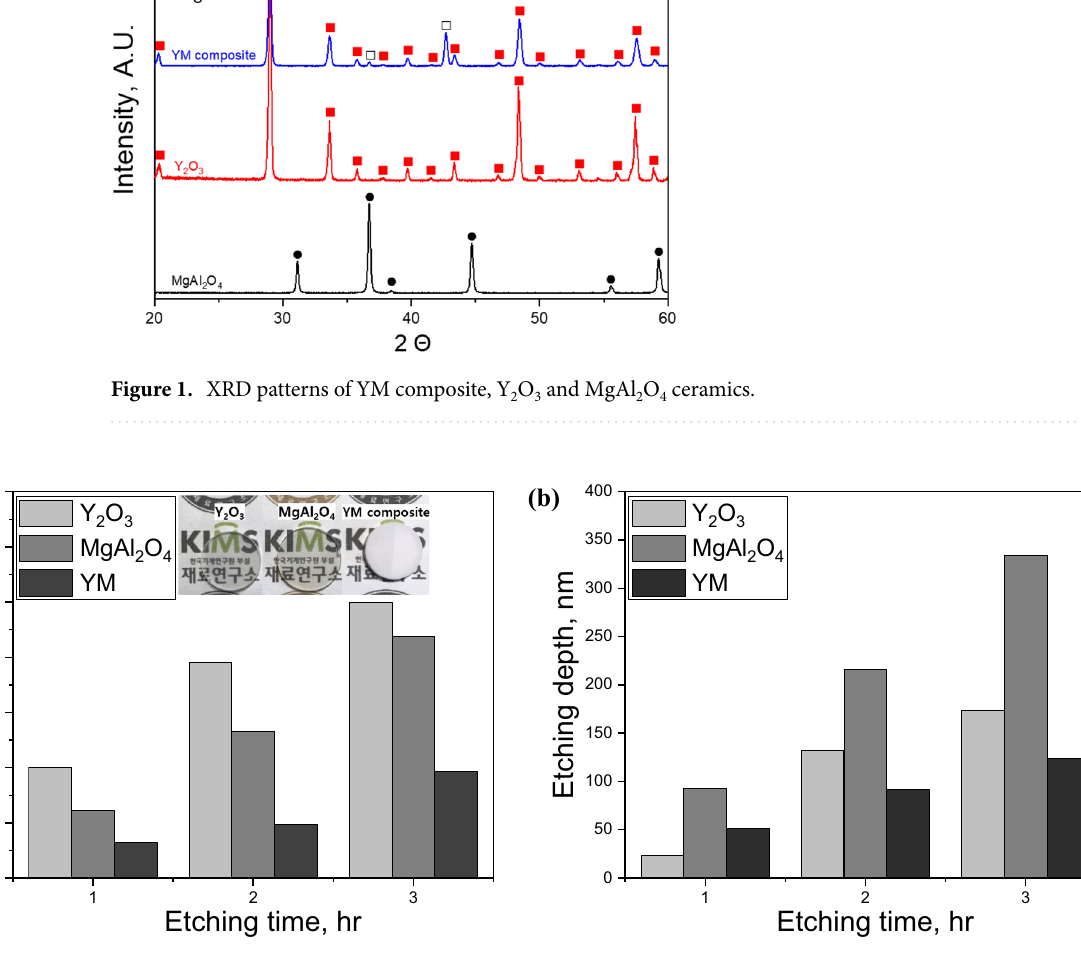
Figure 2. The measurement of ( a ) mass loss and ( b ) etching depth; the corresponding ceramic specimens after plasma etching are shown in the inset of Fig. ( a ) of which right half of each specimen was